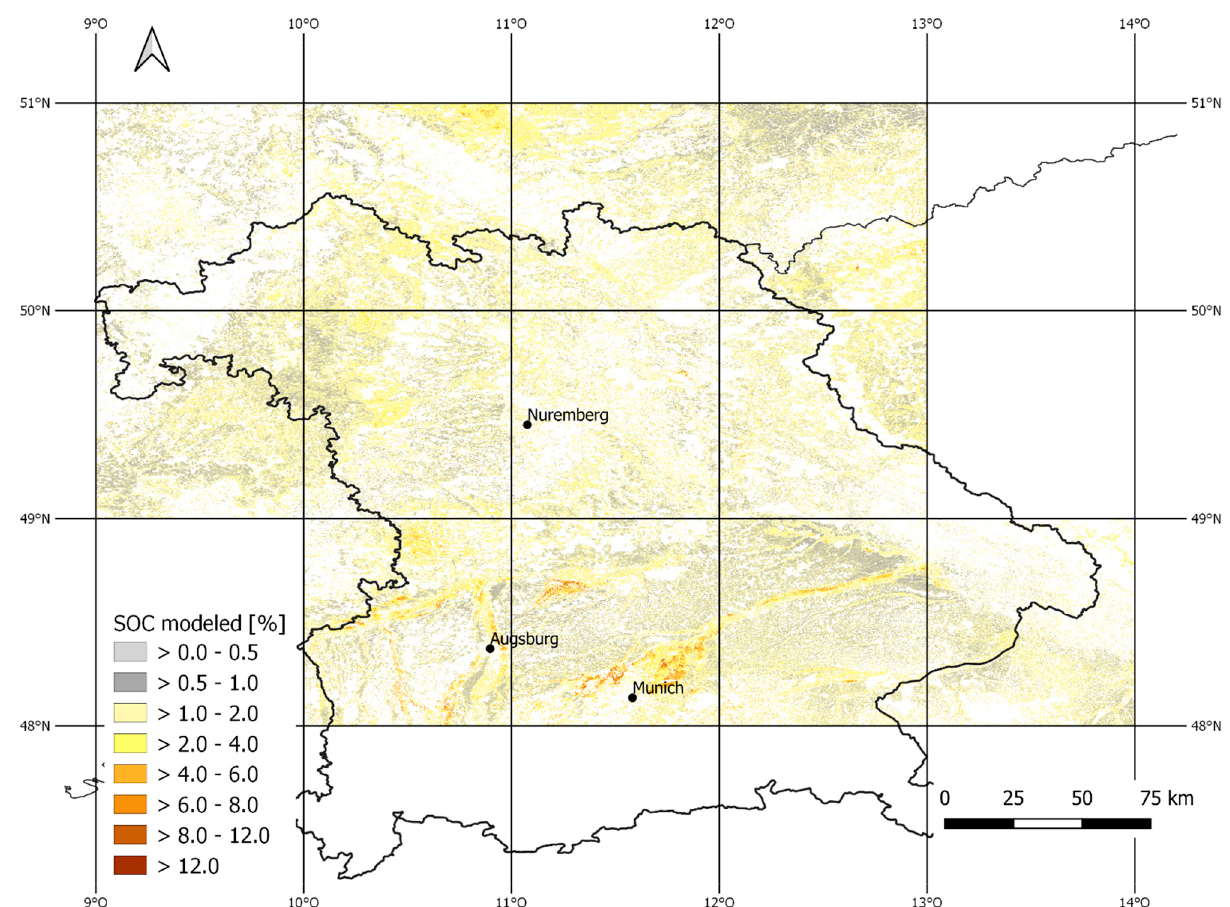
Figure 10. Spatial prediction of the SOC contents based on the RF (RI_all) model.